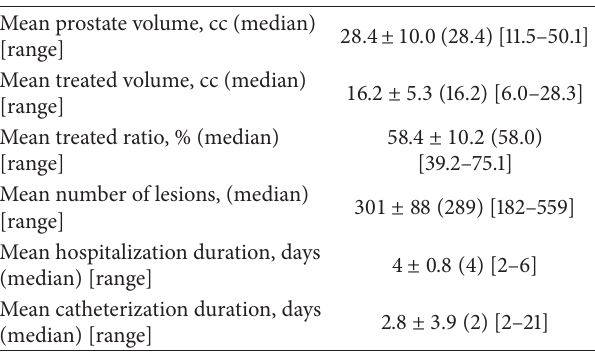
Table 2: Perioperative data.